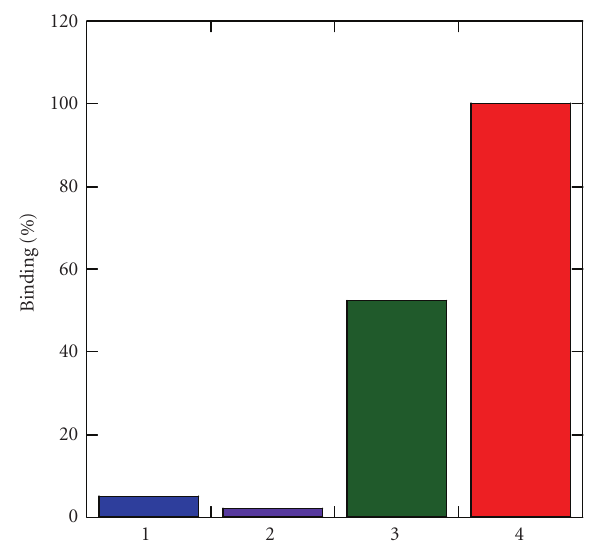
Figure 4: Surface binding plate assay of QD’s with di ff erent surface ligands: ( 1 ) DHLA, (2) DHLA–PEG600, (3) DHLA:DHLA–TEG– Biotin (at 4:1 ratio), and (4) DHLA–PEG600 : DHLA–TEG–Biotin (at 4: 1 ratio). 540nm emitting QD’s were